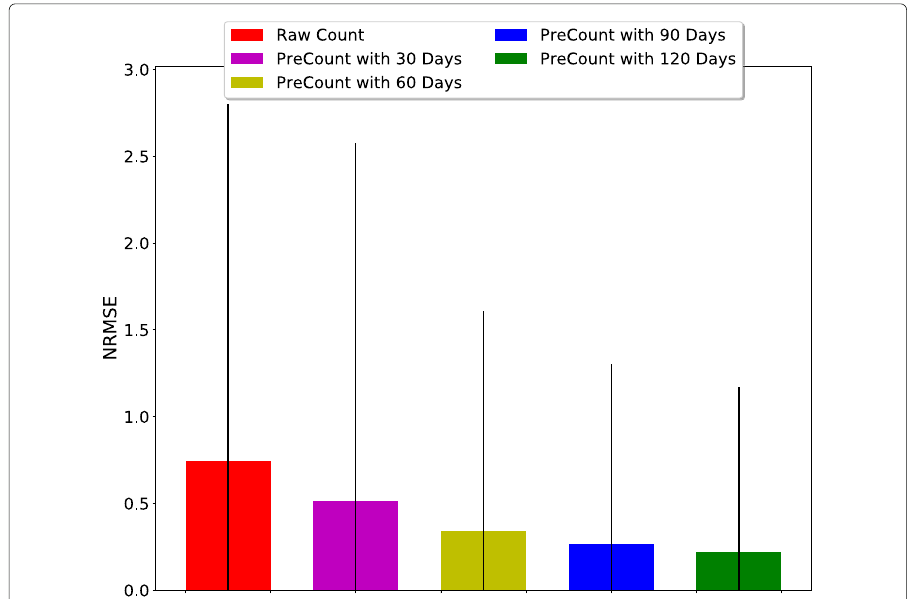
Fig. 10 CC r versus PreCount with varying size of training dataset for the MALL building